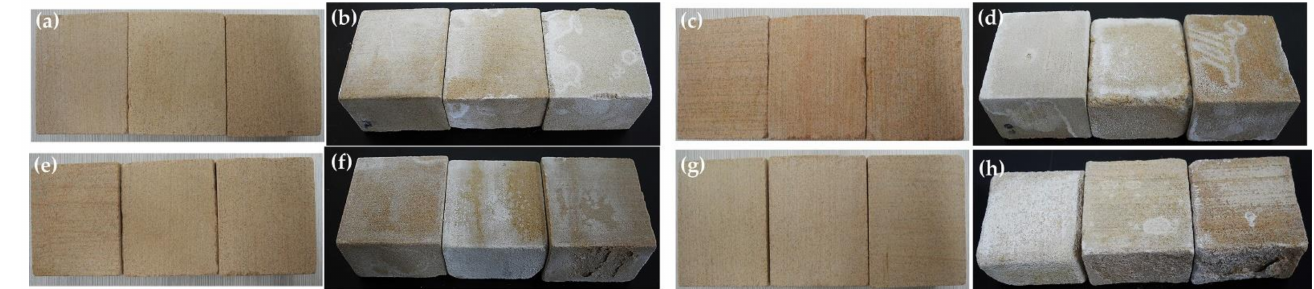
Figure 8. The morphologies of sample SiON ( a , b ), sample B72 ( c , d ), sample PDMS ( e , f ), and sample Blank ( g , h ) before and after the salt weathering experiment.